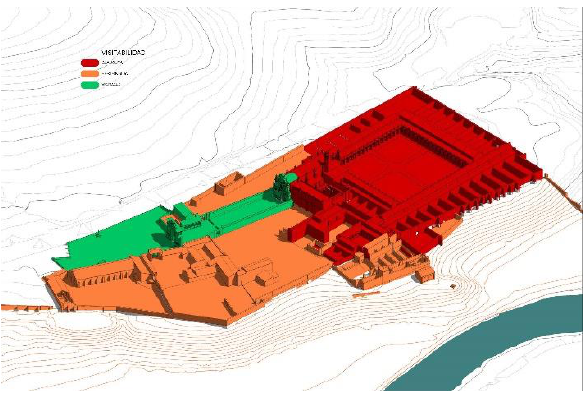
Figure 9: Visits view: open, restricted, cloister.